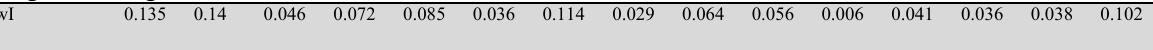
Integrated weights wI